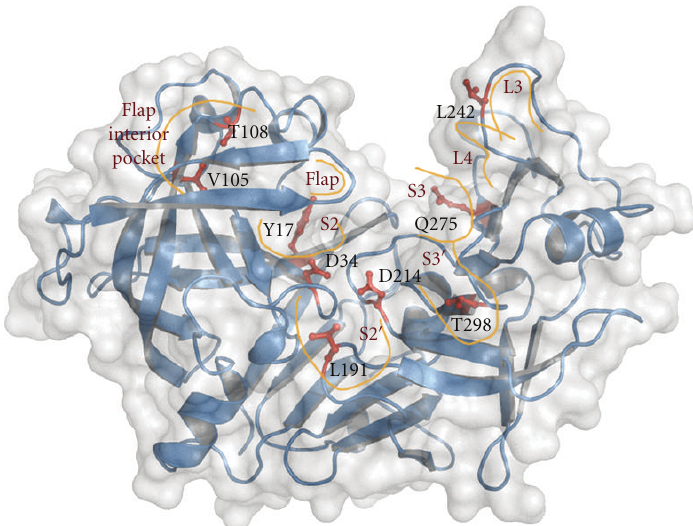
Figure 2: Top view of the surface representation of plasmepsin II. The seven new functional residues proposed by Valiente and colleagues [5], and the catalytic aspartic residues, are shown in stick representation. The enzyme subsites, the flap, and the flexible loops L3 and L4 (identified by Bhargavi and coworkers [6]) were sketched in